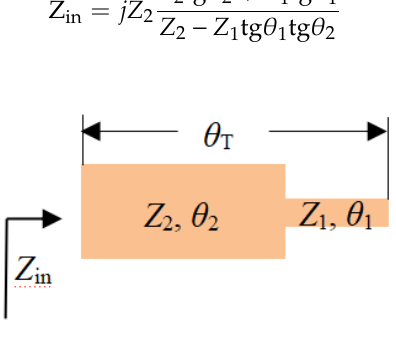
Figure 2. Structure of the stepped impedance resonator (SIR).